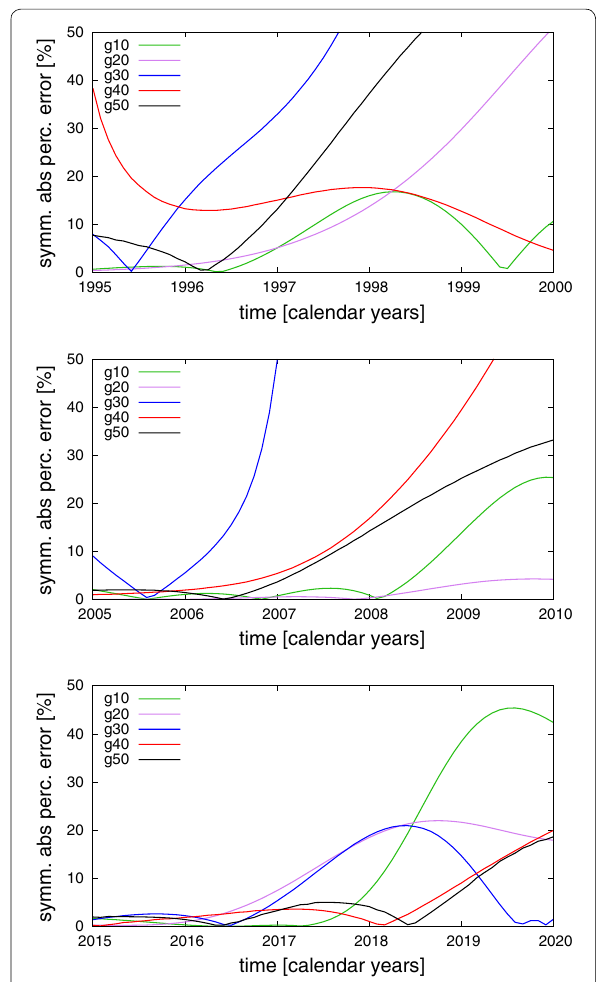
Fig. 10 Evolution of the sAPE(t) of zonal secular variation coefficients based on Model 1 of the three forecasts experiments started in 1995 (top panel), in 2005 (middle panel) and in 2015 (bottom panel), respectively